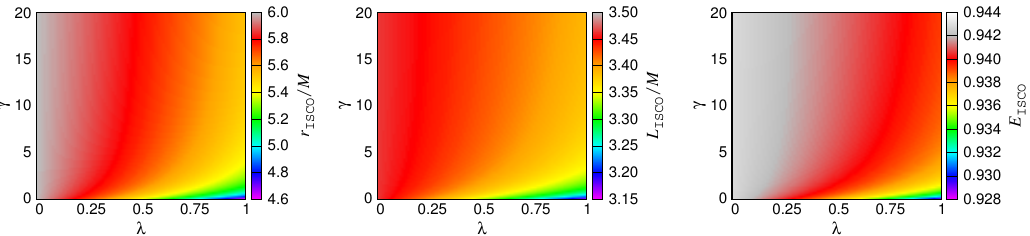
Figure 3. r ISCO / M , L ISCO / M , and E ISCO of a timelike particle around RGISBHs with respect to λ and γ